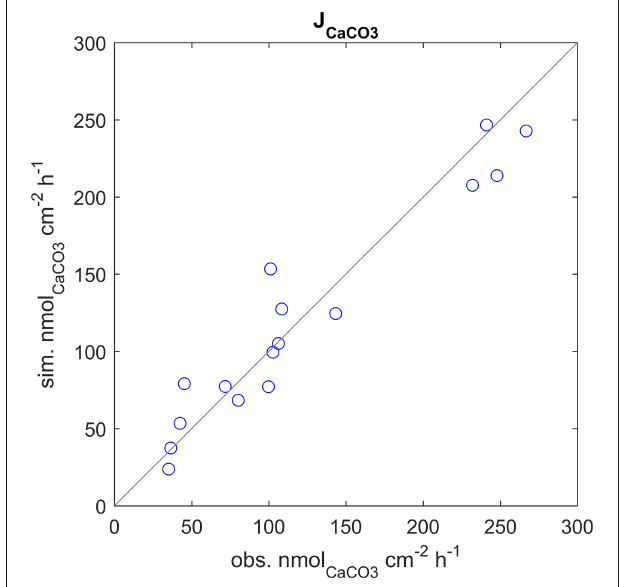
FIGURE 3 | Calcification rates at all experimental setups, observed vs. simulated values. Note that the observed calcification rates were used to calibrate the